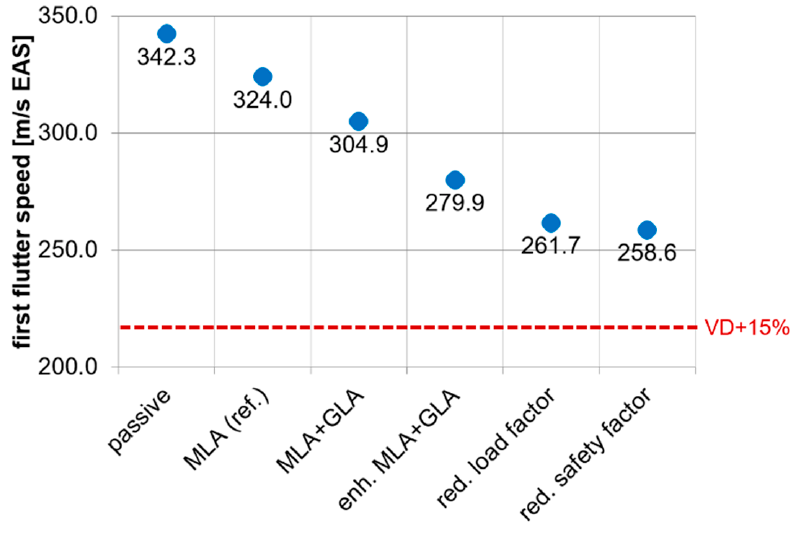
Figure 47. Overview of the flutter speed.